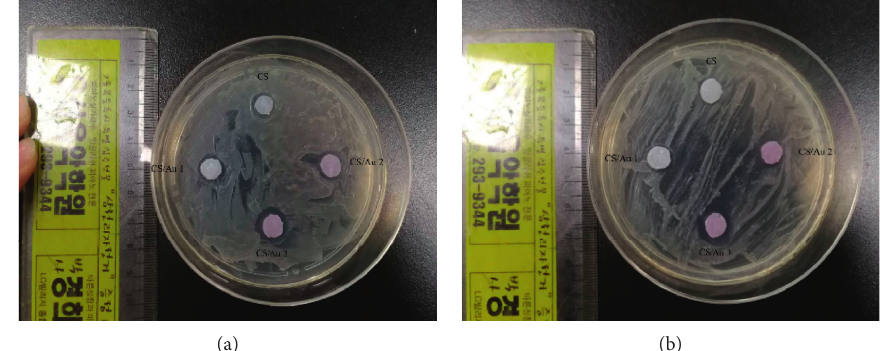
Figure 3: Inhibition zone of CS, CS/AuNPs 1 (2mg/mL), CS/AuNPs 2 (5mg/mL), and CS/AuNPs 3 (10mg/mL) against E. coli (a) and S. aureus (b).